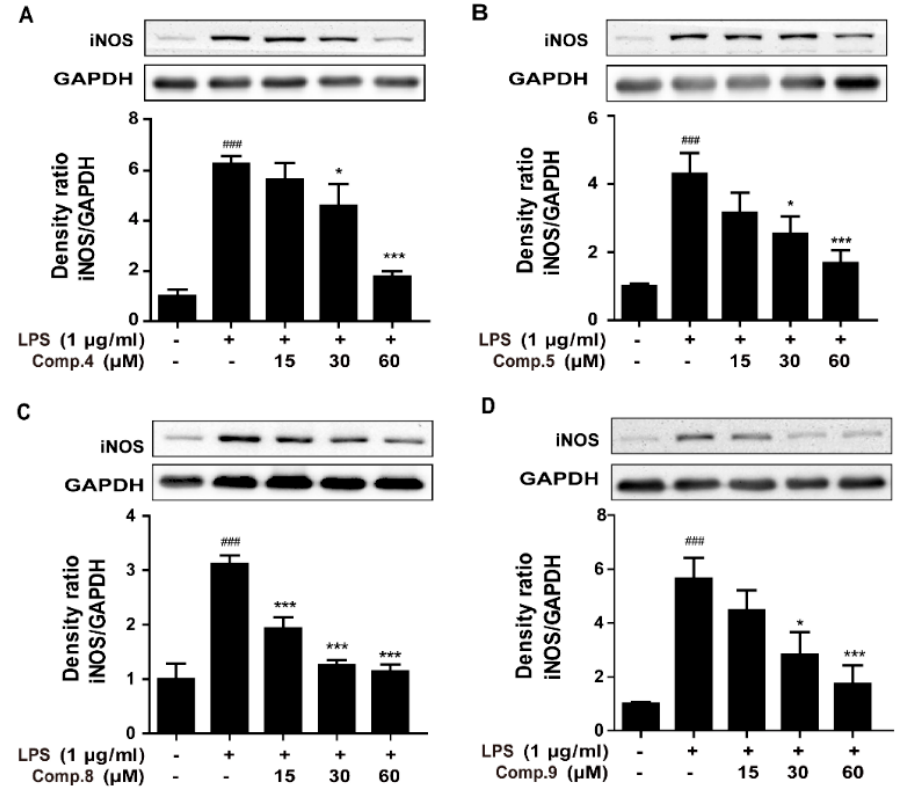
Figure 5. Effect of 4 , 5 , 8 , and 9 on iNOS expression in LPS-induced RAW 264.7 cells. Cells were pretreated with varying concentrations (0–60 µ M) of 4 , 5 , 8 and 9 for 2 h and then stimulated with or without LPS (1 µ g/mL) for 24 h. Protein levels of iNOS were evaluated by western blot (( A – D ), for compounds 4 , 5 , 8 , and 9 respectively). The data show mean ± SD values. ### , p < 0.001 was compared to control. *, p < 0.05, ***, p < 0.001 were versus LPS.